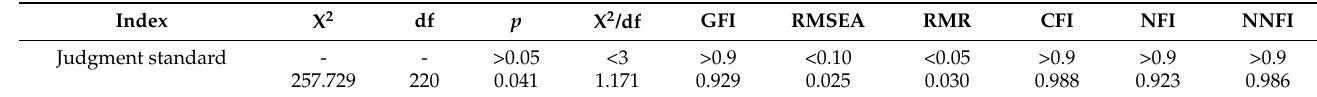
Table 5. Model fit indices.